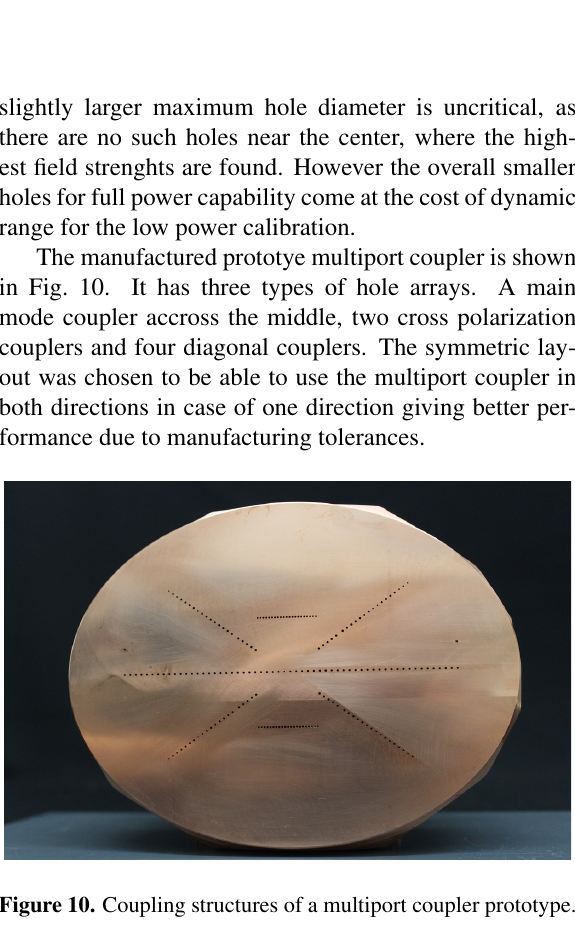
Figure 10. Coupling structures of a multiport coupler